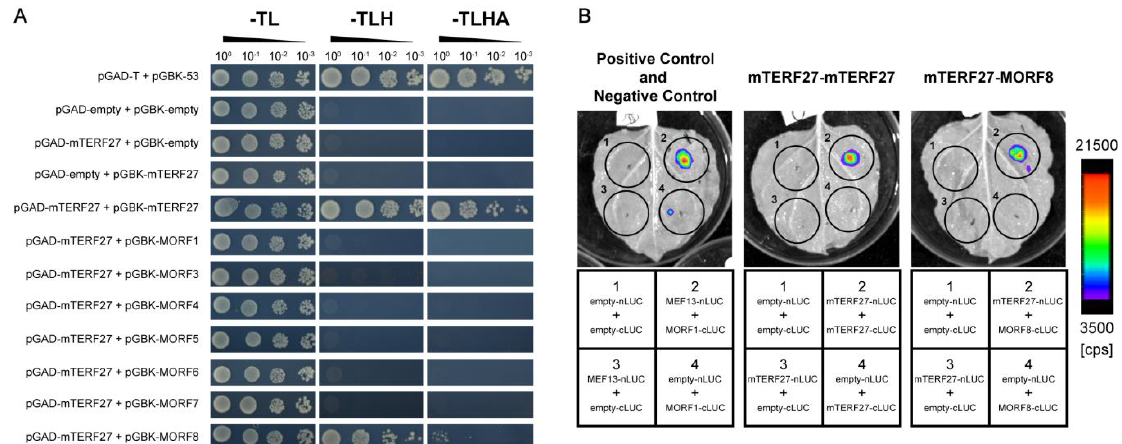
Figure 4. mTERF27 directly interacts with mTERF27 and MORF8. ( A ) Yeast two-hybrid assays showing interactions between mTERF27 and MORF8. pGAD, pGADT7 with the GAL4 activation domain; pGBK, pGBKT7 with the GAL4 DNA binding domain; -TL, SD/-Trp-Leu dropout medium; -TLH, SD/-Trp-Leu-His dropout medium; -TLHA, SD/-Trp-Leu-His-Ade dropout medium. The 53-T interaction were used as positive controls. ( B ) Firefly luciferase complementation assays showing mTERF27-mTERF27 and mTERF27-MORF8 interactions in planta. MEF13-MORF1 interaction were used as positive controls [34] . Color scale represents the luminescent signal intensity measured by cps (counts per second).